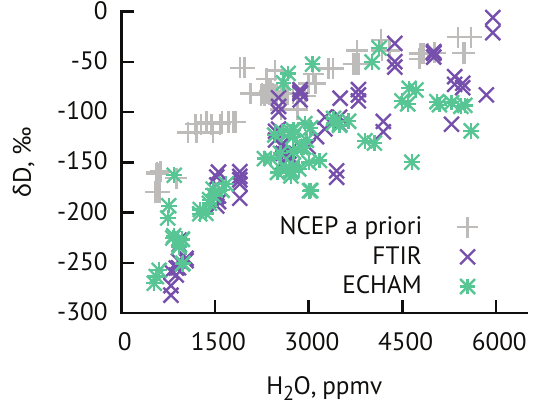
Figure 10. H 2 O vs. δ D plots from a priori for FTIR retrieval, FTIR retrievals, and ECHAM5-wiso data. Most of the retrieved δ D varia- tions are already accounted for by the a priori